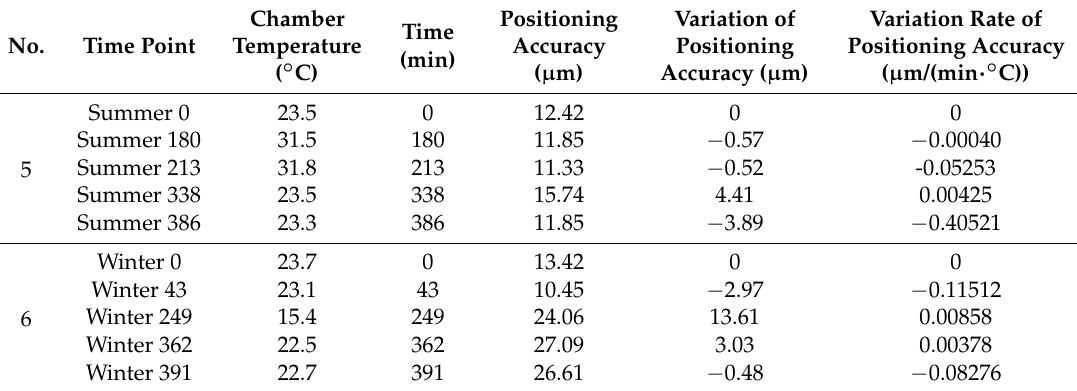
Table 2. Corresponding positioning accuracies and corresponding variations of a periodically-moving carrier operating in the summer daytime and winter nighttime modes,